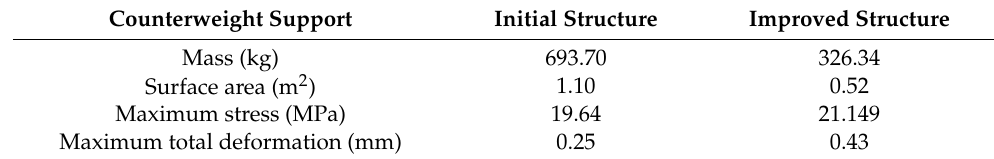
Table 8. Comparison of relevant parameters of counterweight support before and after improvement.